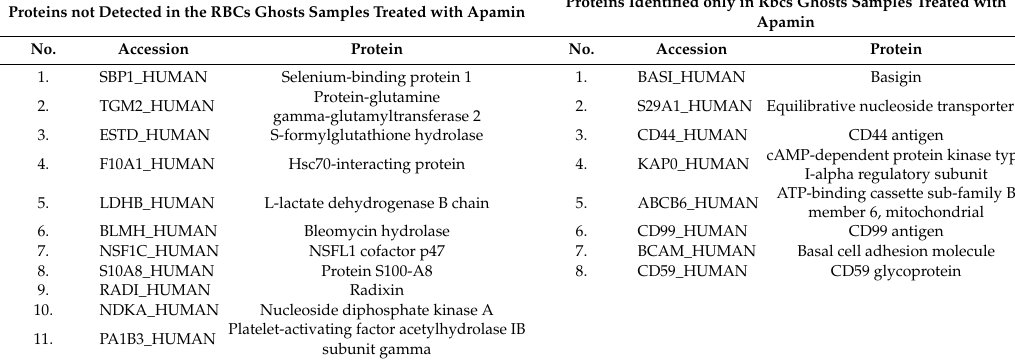
Table 1. Proteins identified and unidentified in red blood cells’ (RBCs) ghosts treated with apamin (10 − 9 and 10 − 6